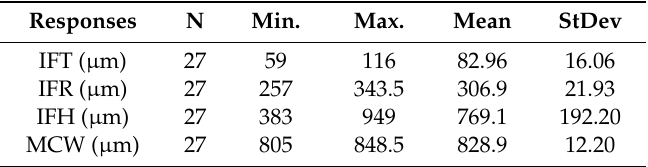
Table 5. Descriptive statistics of